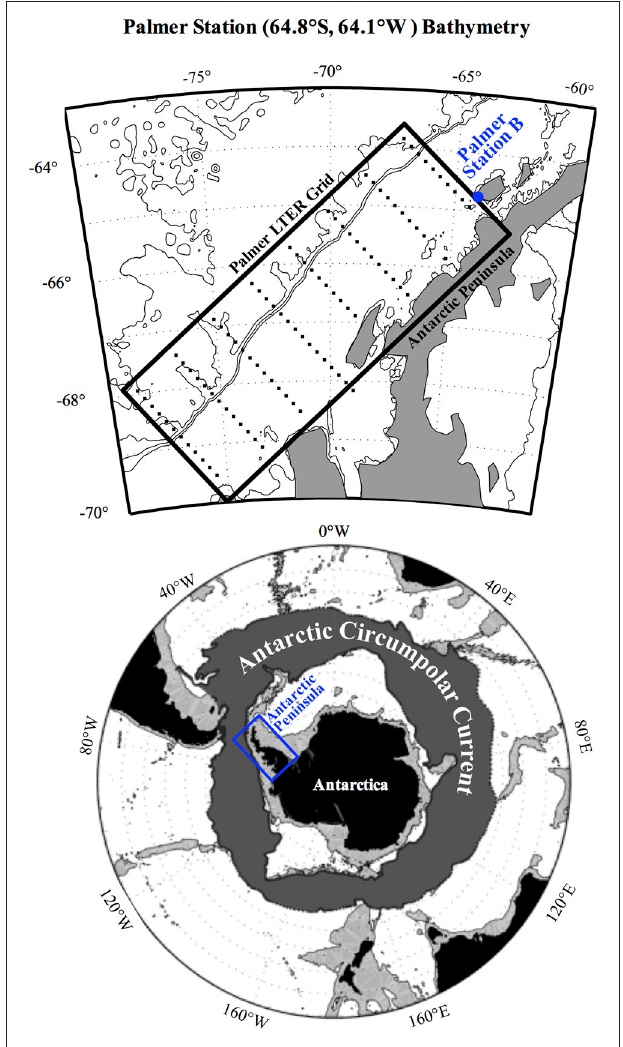
FIGURE 1 | Location of Palmer Station B in the West Antarctic Peninsula (WAP) adopted from Kim et al.